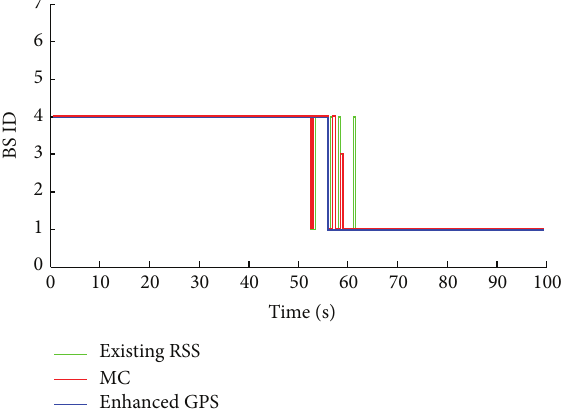
Figure 9: BS prediction with